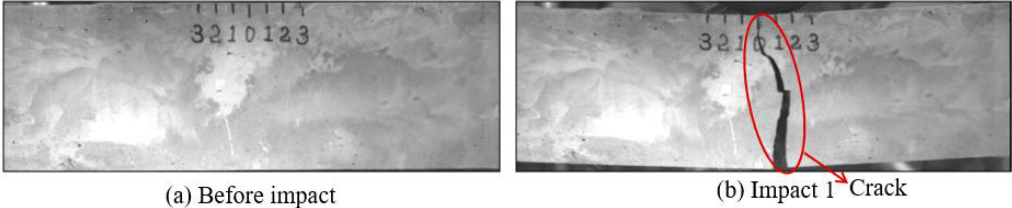
Figure 24. Wavelet packet-based energy plots of the received signal in Mortar-2. Figure 24 . Wavelet packet-based energy plots of the received signal in Mortar-2. Figure 24 . Wavelet packet-based energy plots of the received signal in Mortar-2. Figure 24 . Wavelet packet-based energy plots of the received signal in Mortar-2. Figure 24 . Wavelet packet-based energy plots of the received signal in Mortar-2.